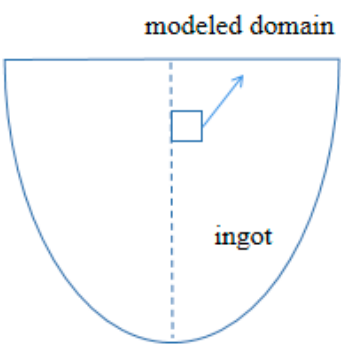
Figure 1. Schematic of the modeled domain.